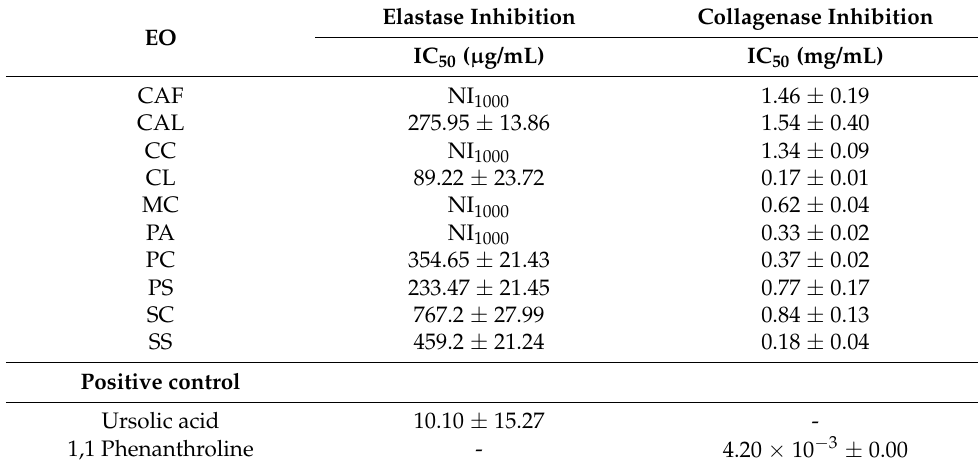
Table 3. Anti-elastase and anti-collagenase activity of studied EOs. Elastase Inhibition Collagenase Inhibition EO IC 50 ( µ g/mL) IC 50